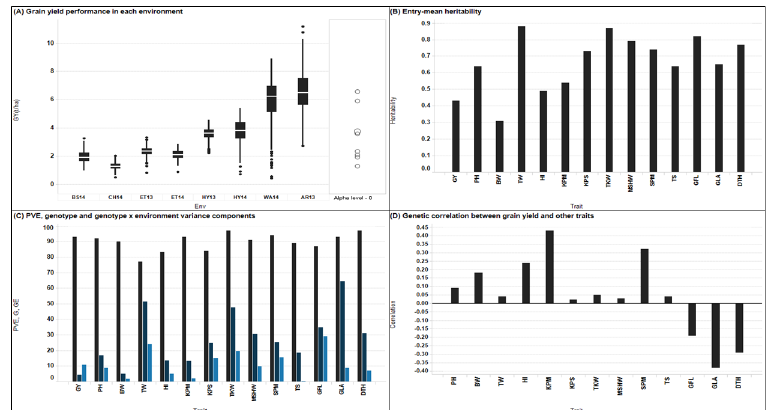
Fig 1. Visualization of phenotypicperformance (A) Individualenvironment boxplotfor grainyield. The y -axisis grainyieldin t ha 1 and the x -axisrepresents environments. The mid linein the box representthe median,the lowerand upperhorizontallinesof the box represent25 and 75 percentiles,respectively. The lowerwhisker represents the 25 th percentileminus 1.5 × inter-quartile range(IQR) and the upperwhiskeris the 75 th percentile plus1.5 × IQR. (B) Entry-meanheritability (C) Percentage of phenotypic varianceexplained (PVE), genotype and genotypex environmentcomponents(D) Genetic correlationbetweengrainyieldand agronomictraits.